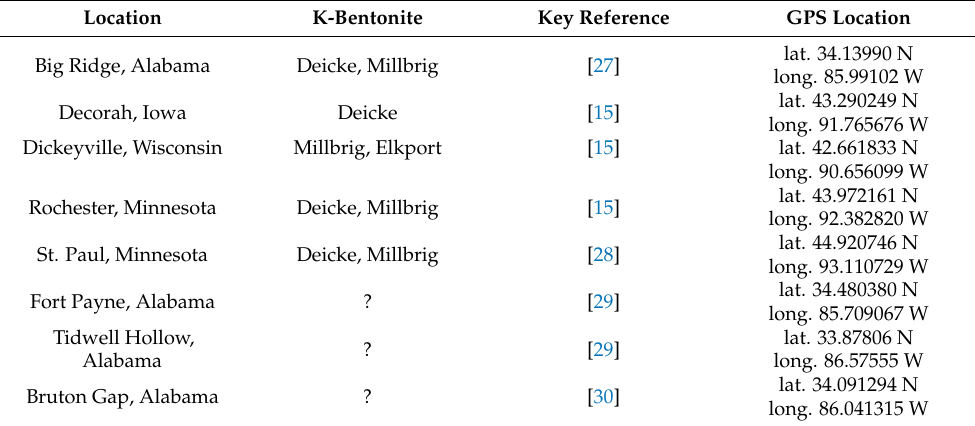
Table 1. Location information for each sample, the name of each K-bentonite that was collected at each section, and the key references for each sample. “?” refers to K-bentonites that have been tentatively identified, but not yet geochemically